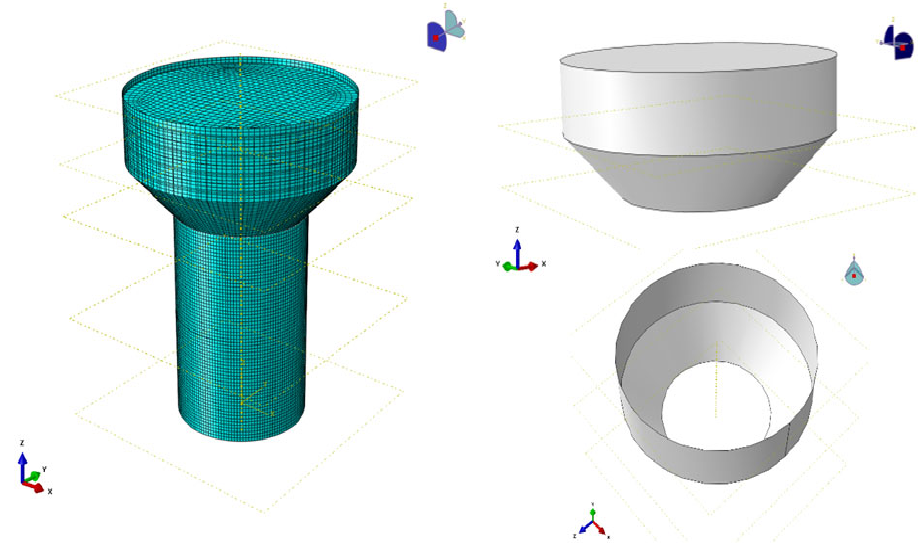
Figure 5. FEM representation of the elevated tank model.